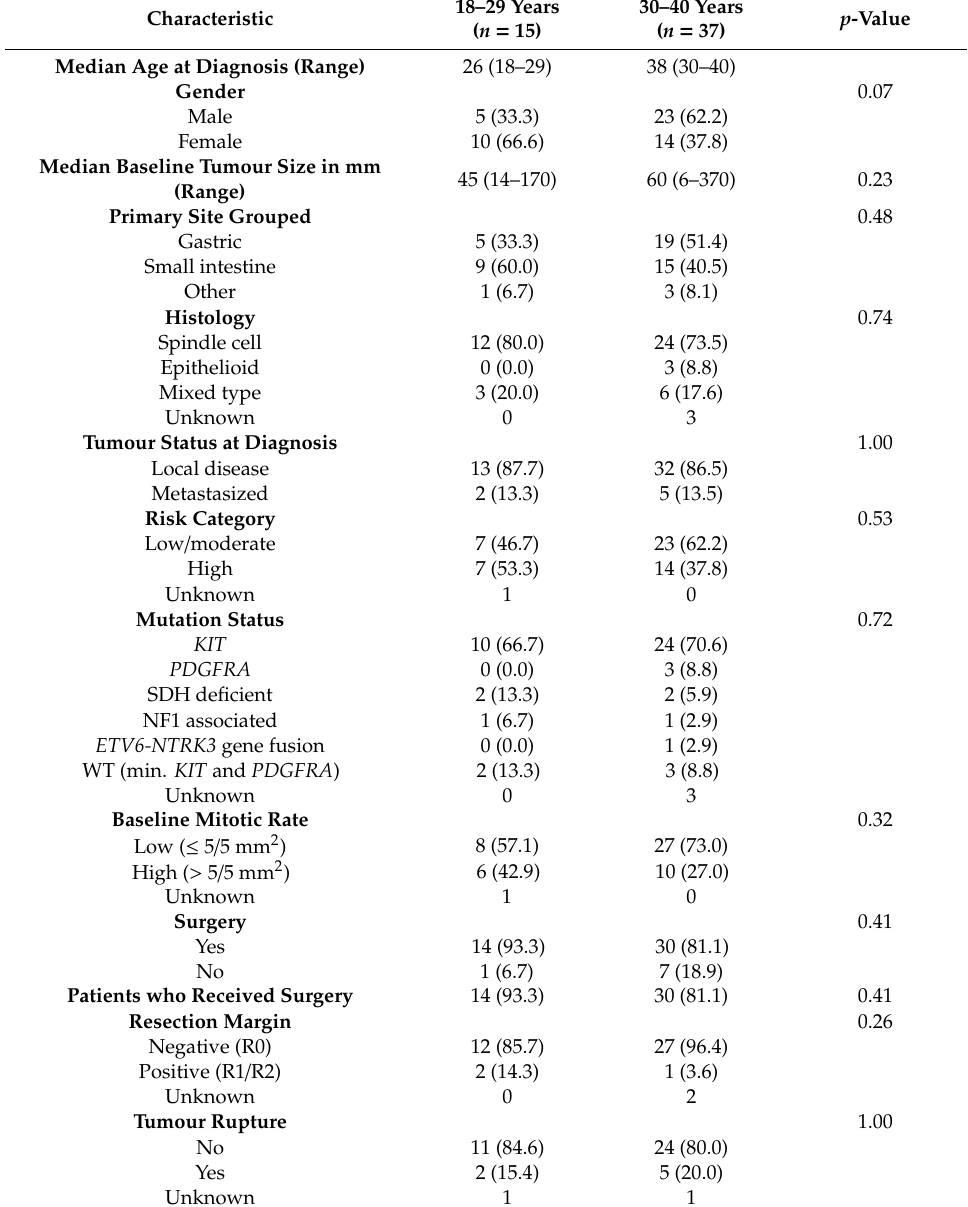
Table 3. Clinical and tumour characteristics within the young-adult age group.